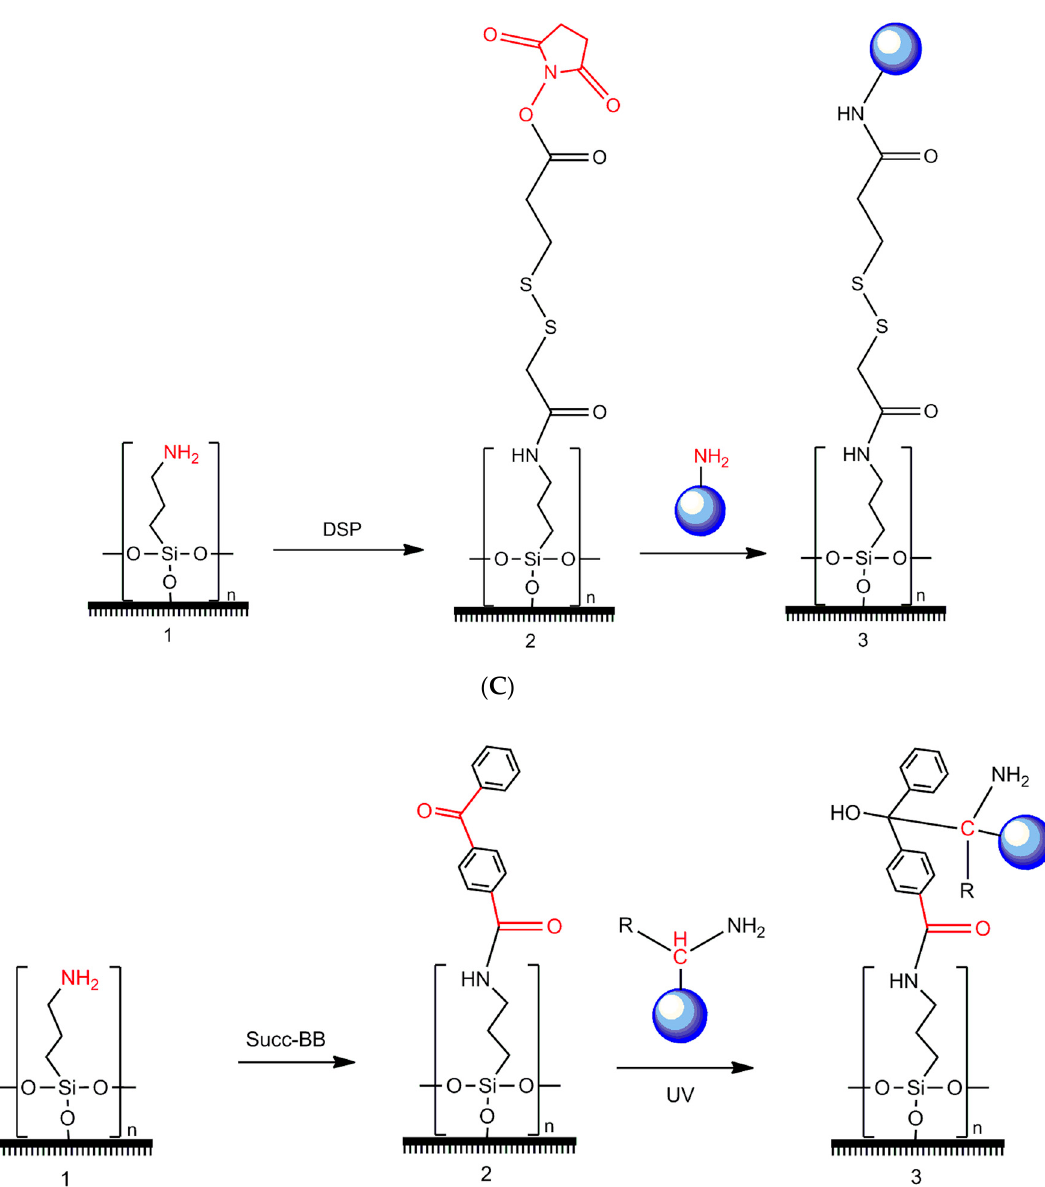
Figure 1. Schematic representation of activation of amino mica substrate surface with a crosslinker and subsequent immobilization of a protein under study onto the activated surface. Panels ( A ) and ( B ) show structural formulae of DSP and SuccBB, respectively. Panels ( C ) and ( D ) schematically illustrate modification of the substrate surface with DSP and SuccBB, respectively, and subsequent immobilization of protein onto the activated surface. 1—amino mica surface; 2—crosslinker-activated substrate surface; 3—substrate surface with immobilized protein. Functional groups of compounds directly involved into chemical reactions on the surface are shown in red. Blue circles indicate protein macromolecules: horseradish peroxidase (HRP) or human serum albumin (HSA).